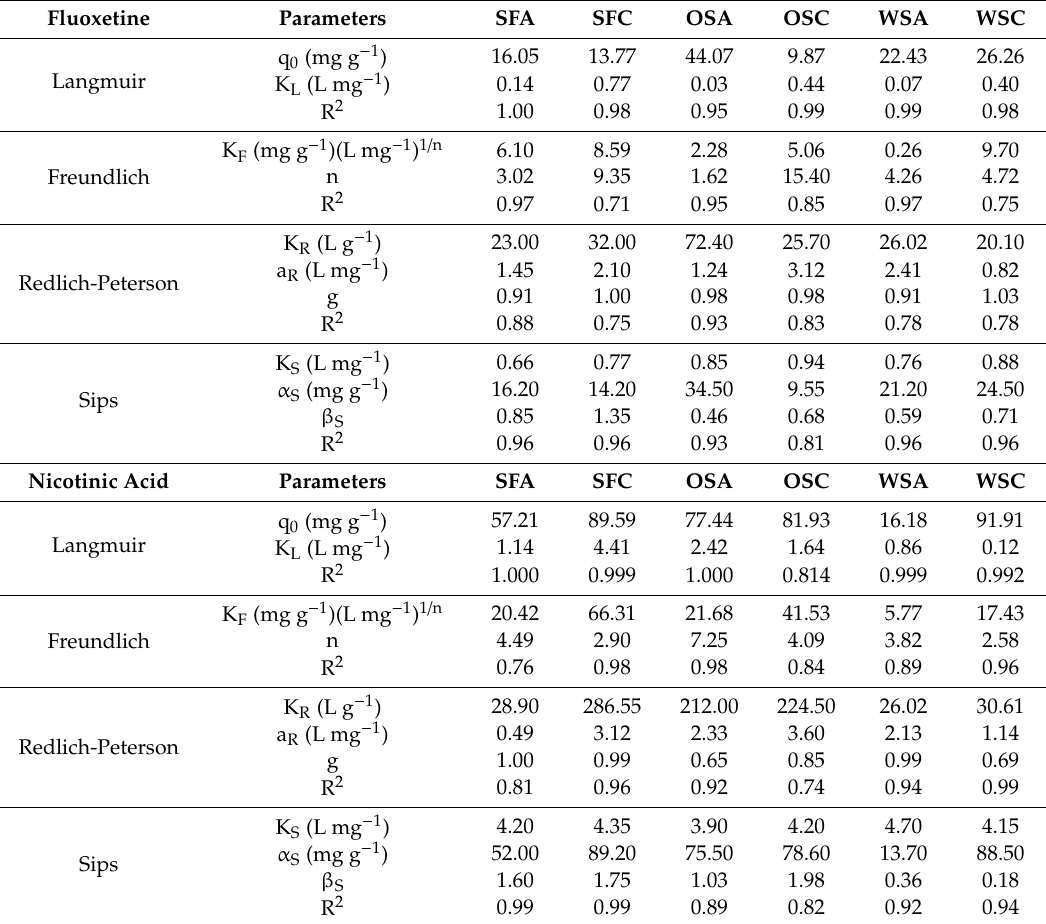
Table 1. Model parameters and correlation coe ffi